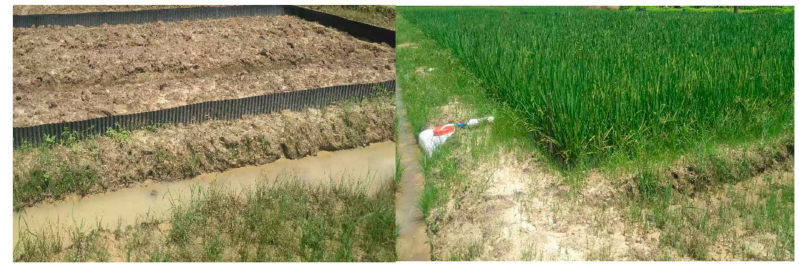
Figure 2. Installation of runo ff collection system for monitoring N